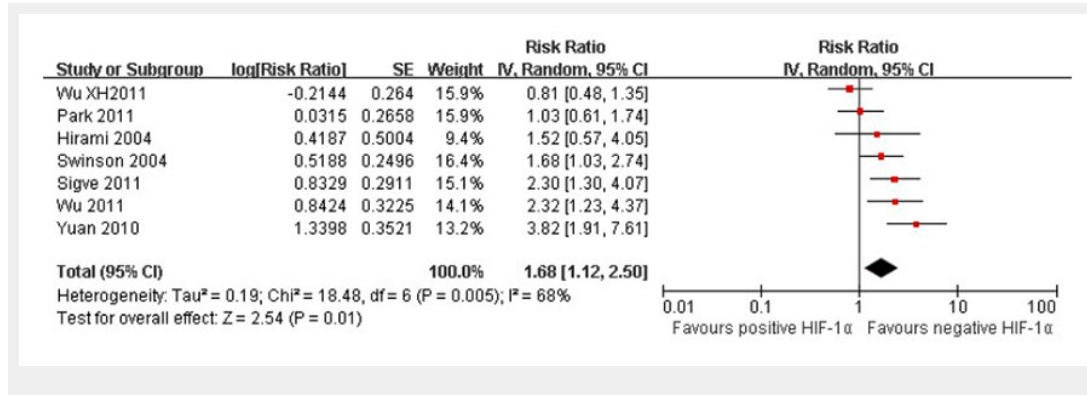
Figure 5 Forest plot of association between HIF-1α expression and overall